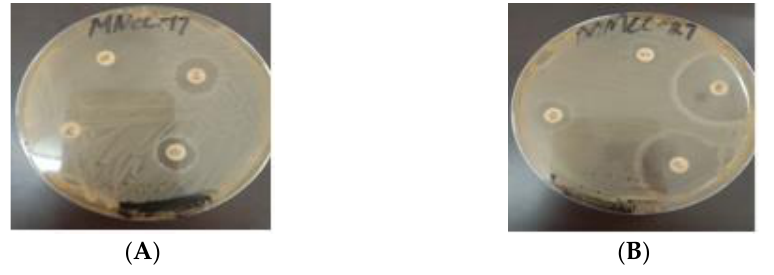
Figure 7. Antibiotic activity: ( A ) NMCC-17; ( B ) NMCC-27. Various types of pathogenic bacterial species can also be inhibited by probiotic bacteria. In this study, E. coli (ATCC8739), Pseudomonas aeruginosa (ATCC9027), Staphylococcus aureus (ATCC6538), Listeria monocytogenes (ATCC13932), and Bacillus cereus (ATCC-11778) strains were used as indicator pathogens. Impressively, NMCC-14 exhibited resistance against all pathogenic strains; thus, it could be exploited as a potential antimicrobial probiotic candidate against animal pathogens. The inhibition activity of the bacterial isolates against various food-borne pathogens is reported in Table 5. Antibacterial activity of LAB strains against food pathogens and diameter (mm) of the re- spective inhibition zones.